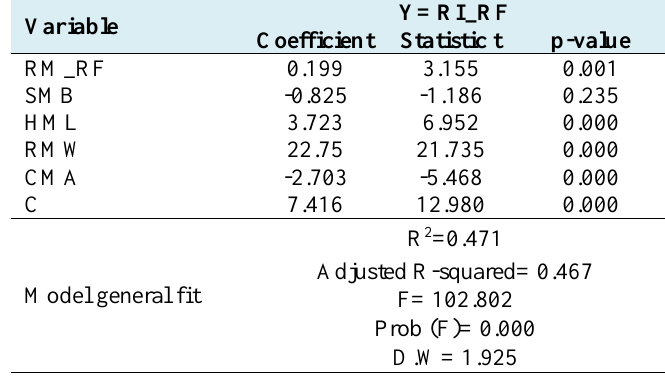
Table 8. Estimation of the first research